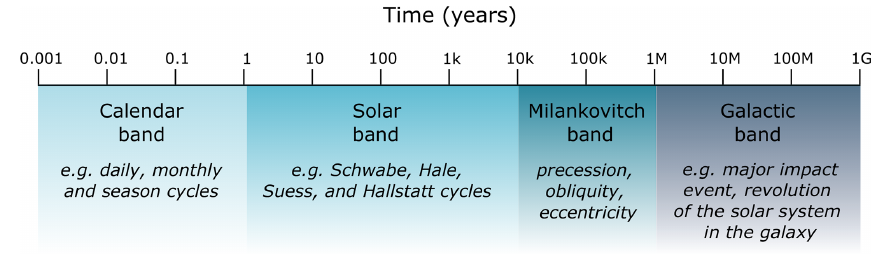
Figure 3. Logarithmic table of the astronomical cycle frequencies (adapted from House, 1995).